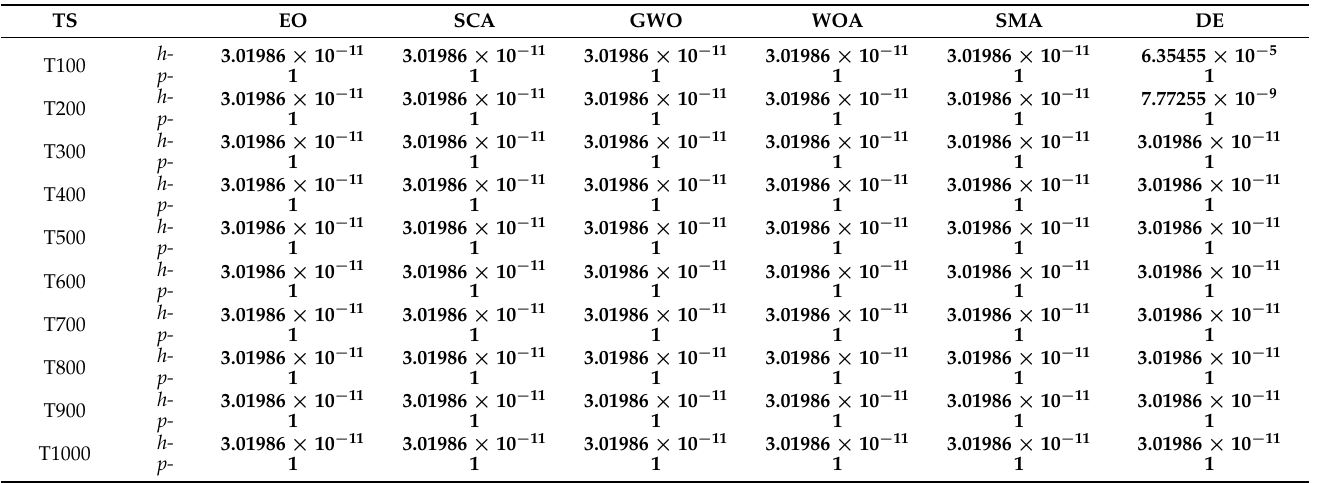
Table A4. Comparison using a Wilcoxon rank sum test between HDE and each compared algorithm, in terms of fitness values.